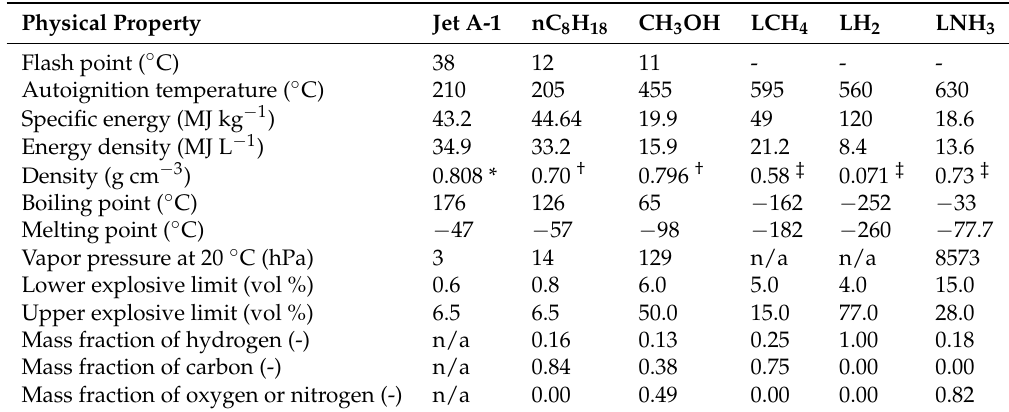
Table 1. Comparison of physical and chemical properties of Jet A-1 and different potential electrofuels (L = liquified; * at 15 ◦ C; † at 20 ◦ C; ‡ at boiling point)